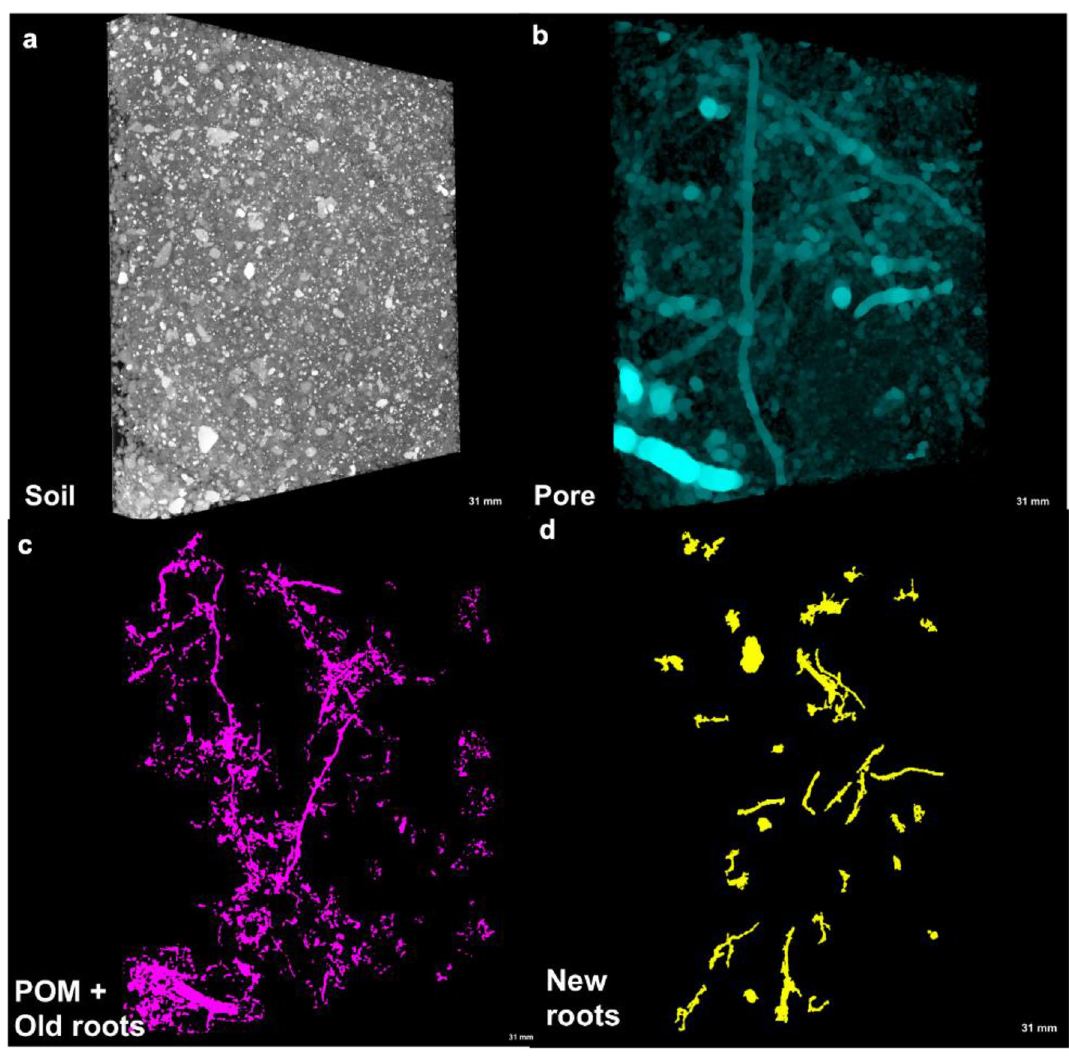
Figure 2. An example of μCT images from switchgrass cropping system μCT scanned at 18.2 μm resolution: ( a ) a 3D grayscale image, ( b ) segmented pores, ( c ) identified particulate organic matter, and ( d ) roots of a newly grown switchgrass plant. Image size is 3.2 × 3.2 × 0.4